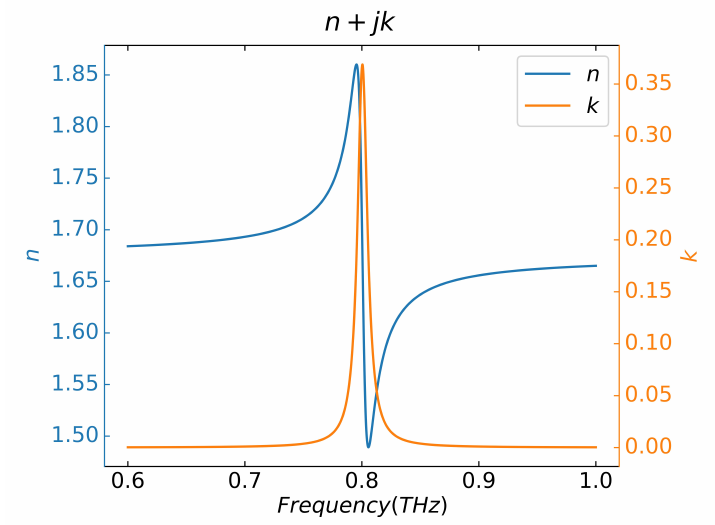
Figure 9. Complex refractive index of tiny biomolecules in THz